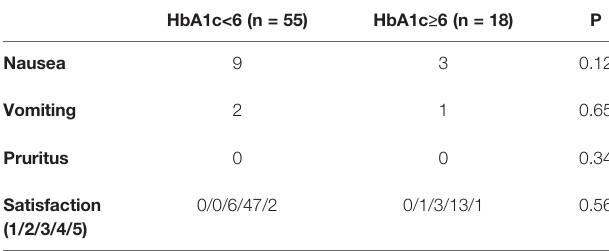
TABLE 5 | Comparison of adverse reactions and patient satisfaction between two groups. HbA1c<6 (n =